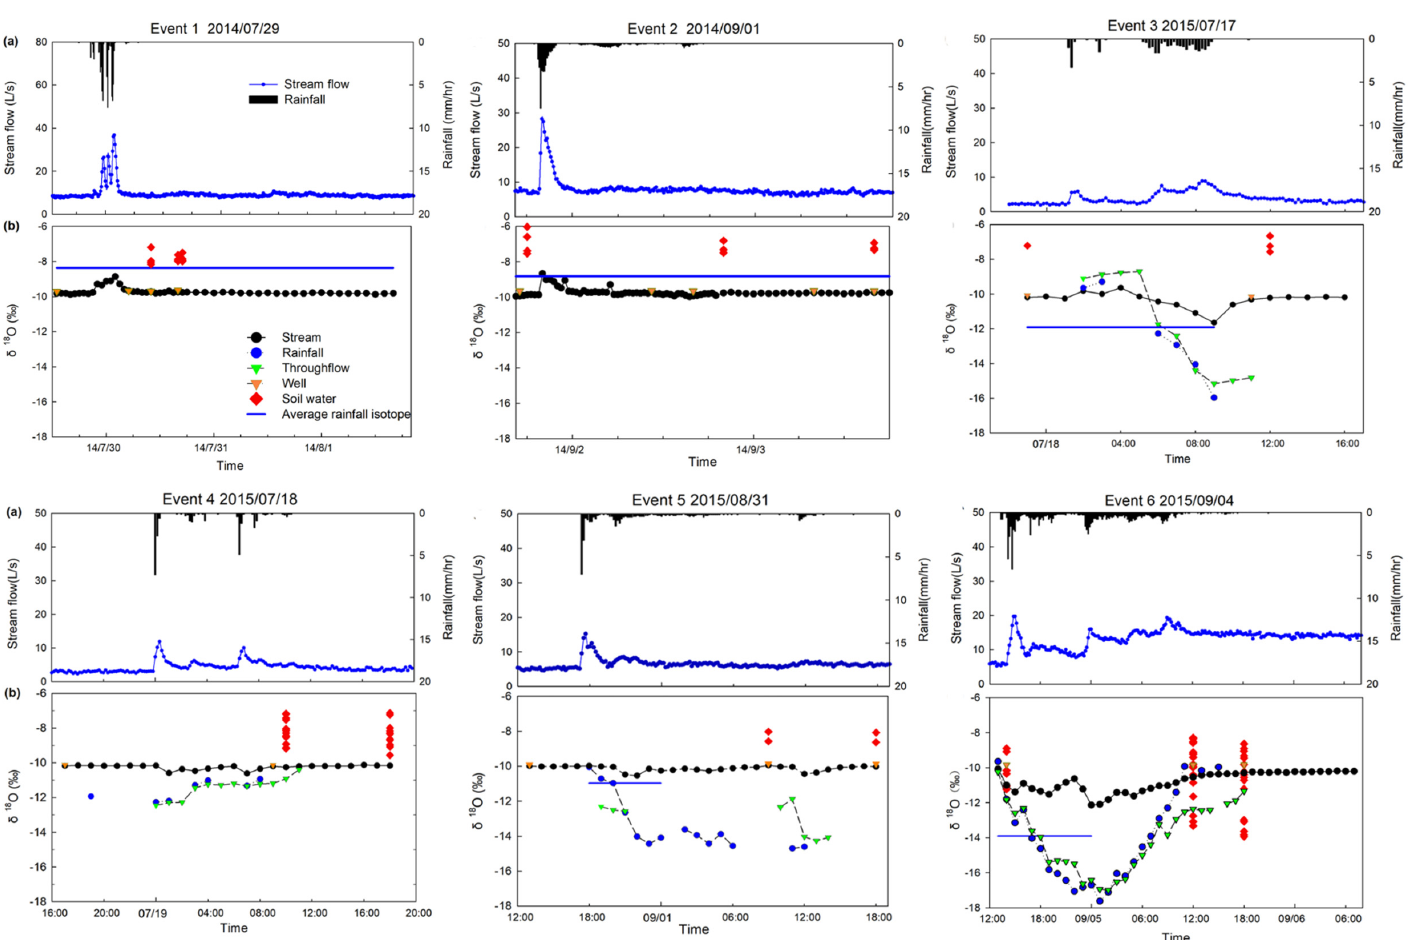
Figure 6. ( a ) Rainfall time series and hydrograph; ( b ) Time series of δ 18 O values of stream water, rainfall water, groundwater and soil water. In Event 1 & 2, one bulk rainfall was collected at the end of storm, blue line represents volume-weighted mean rainfall isotope. In Events 3–6, blue line represents incremental mean weighted rainfall isotope.